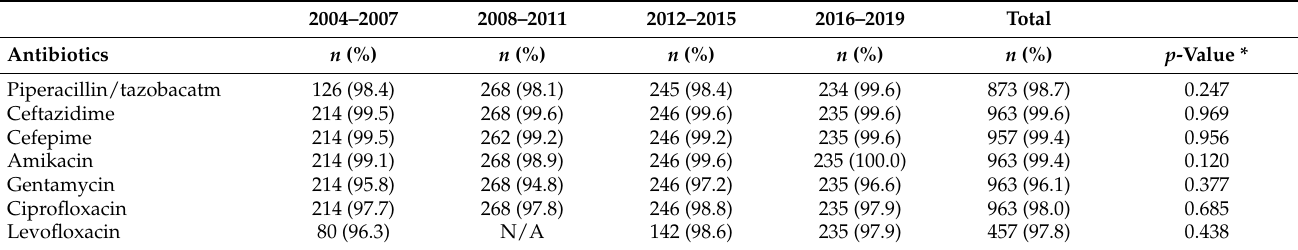
Table 5. Susceptibility of Pseudomonas aeruginosa isolates to the tested